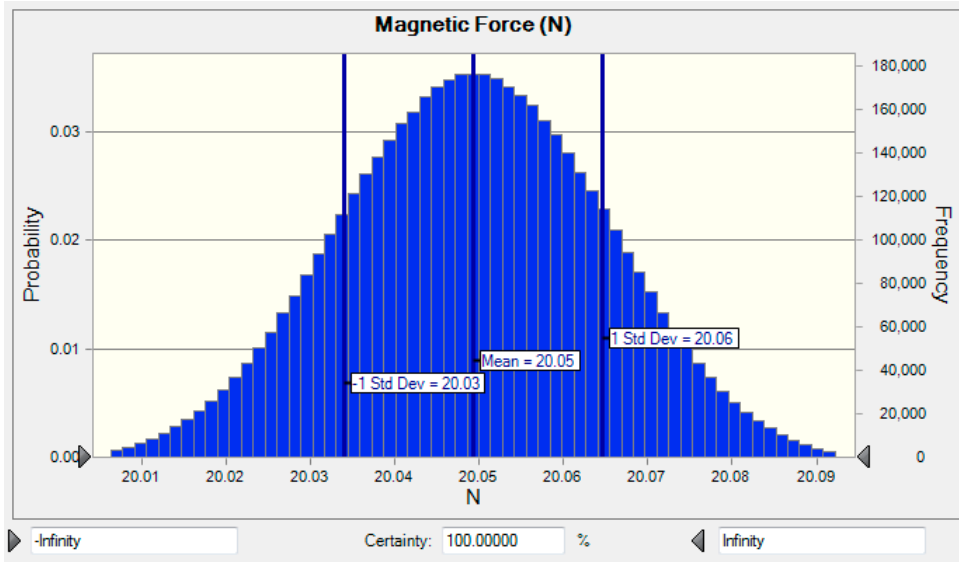
Figure 17. The performance distribution of electromagnetic force by design tolerance.